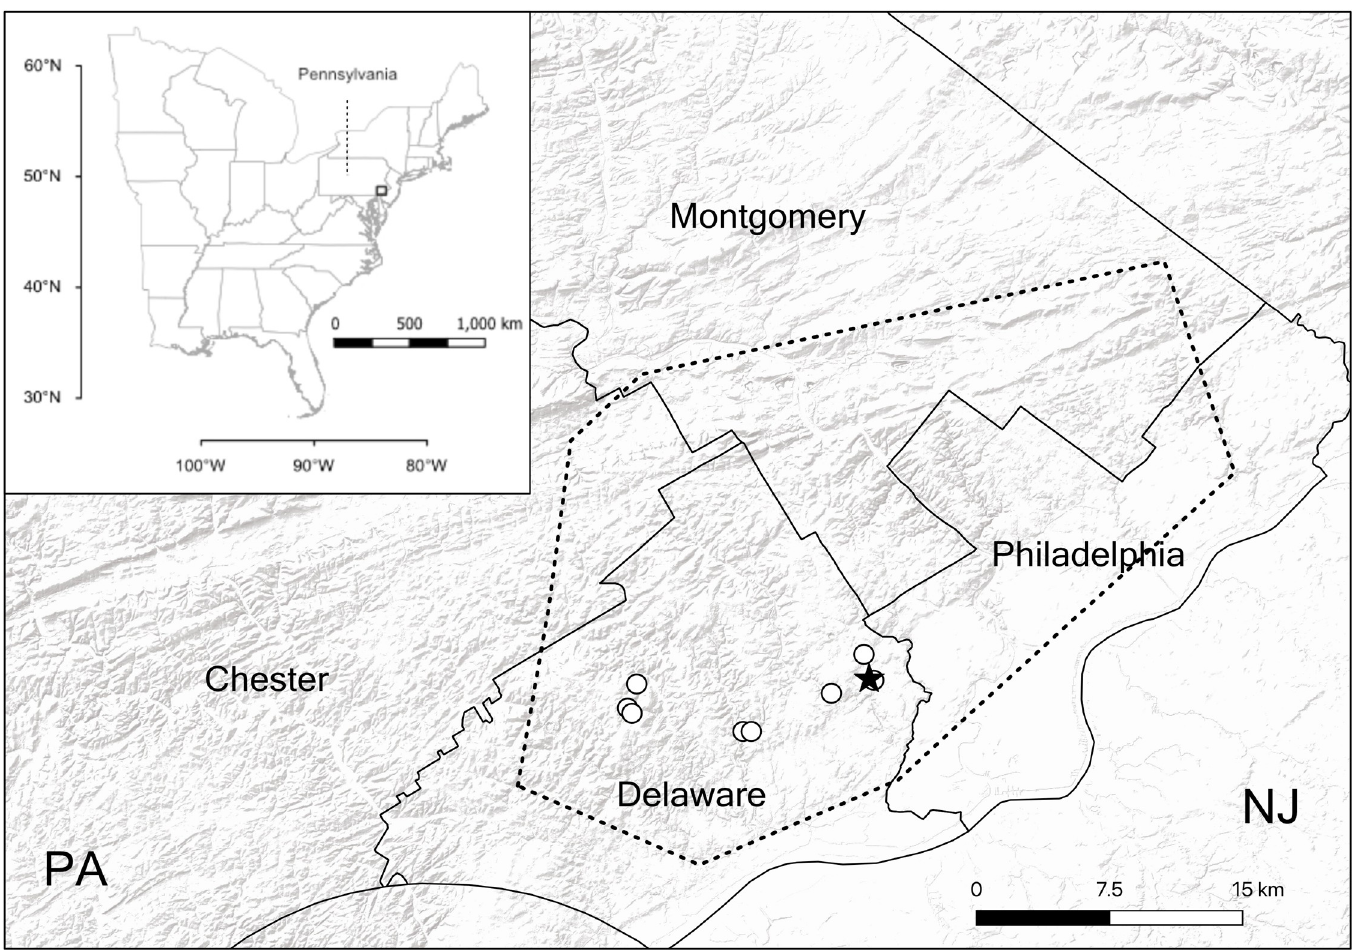
Fig 6. Study sites, counties and estimated area containing Atypus karschi in southeastern Pennsylvania, USA. The hollow circles mark the sites described in this study and the star is the type locality of A . snetsingeri . The minimum convex polygon encloses a nearly contiguous area where vertical purse-webs have been found in a recent visual survey in the region [24], and includes the relatively few sites where a species identification to A . karschi (as A . snetsingeri ) has been made through previous collections, male sightings and female excavation and examination. Sphodros species may also be found in that area as purse-web sites are revisited for species